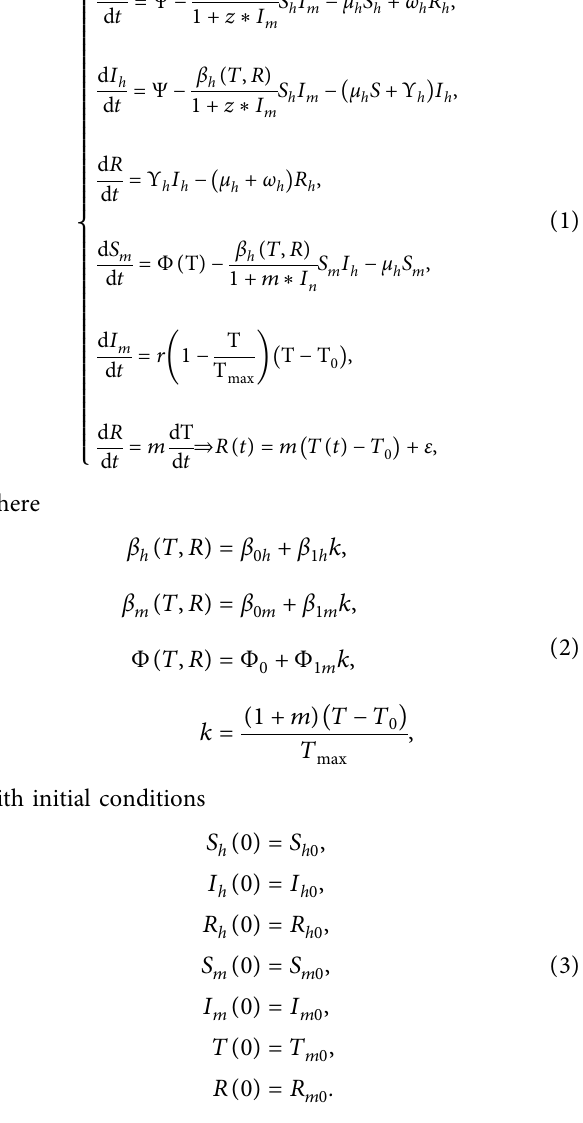
Table 1: Parameters’ description used in system